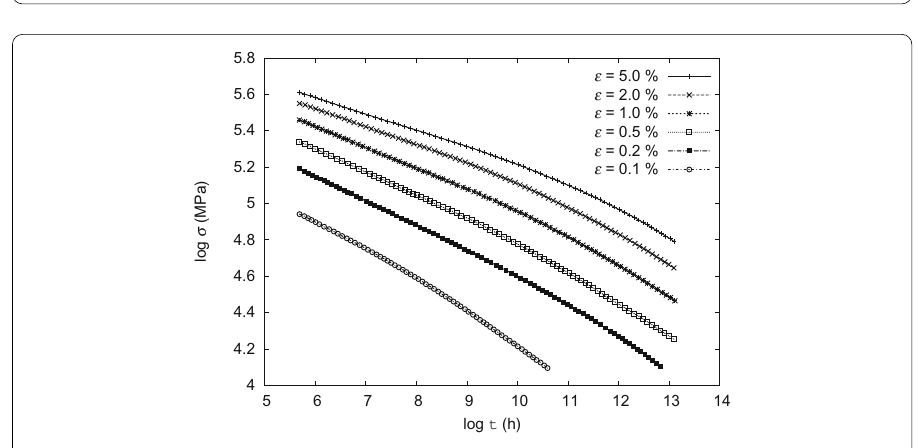
Fig. 6 Experimental stress vs. time responses at different strain levels in the logarithmic plane ( T = 773K) (from Ref.